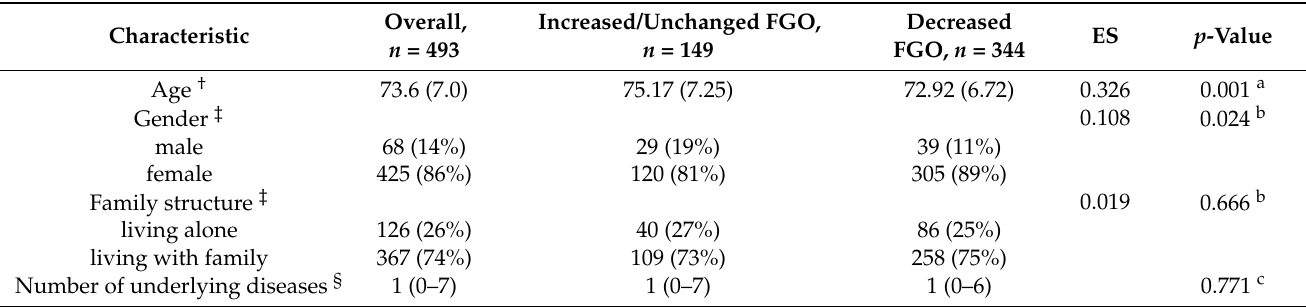
Table 2. Characteristics of the study